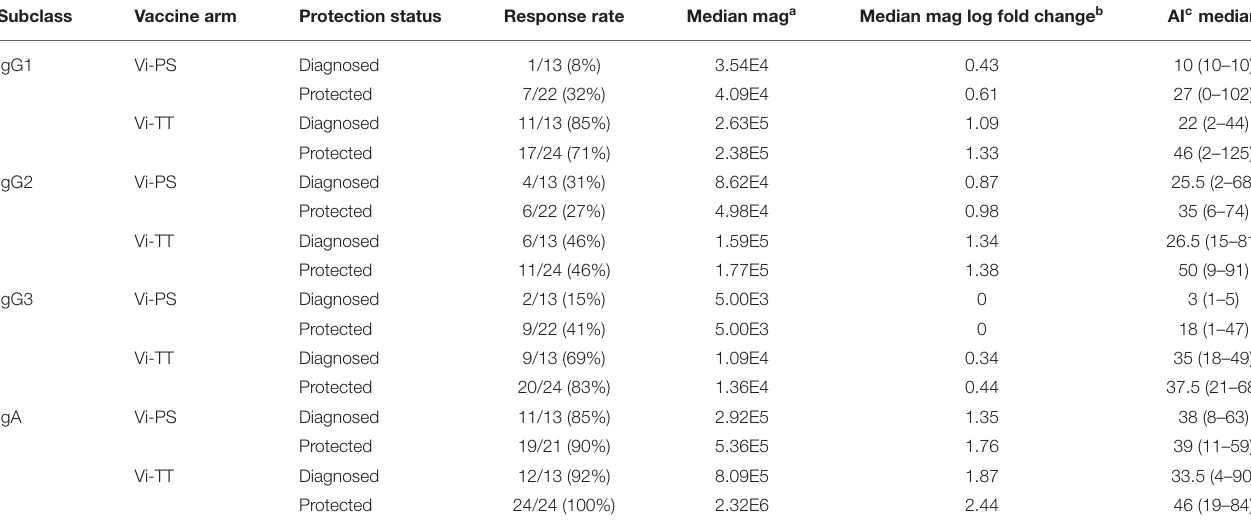
TABLE 2 | Vi Polysaccharide responses by protection status at day of challenge (D0).